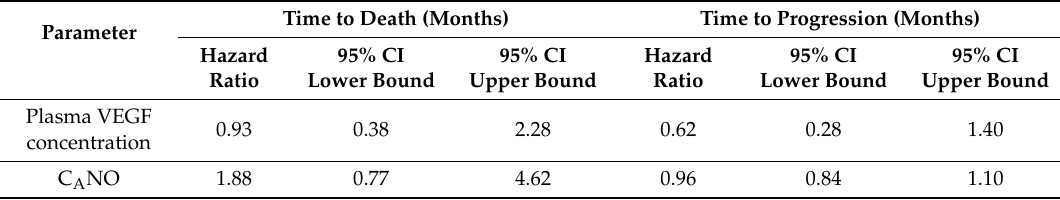
Table 3. Cox regression analysis: prediction of mortality or disease progression using baseline plasma VEGF concentration and